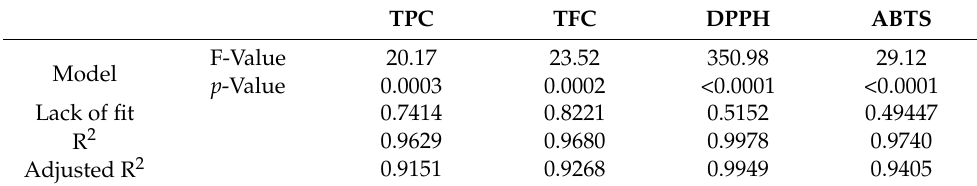
Table 1. Analysis of variance for the fitted model of